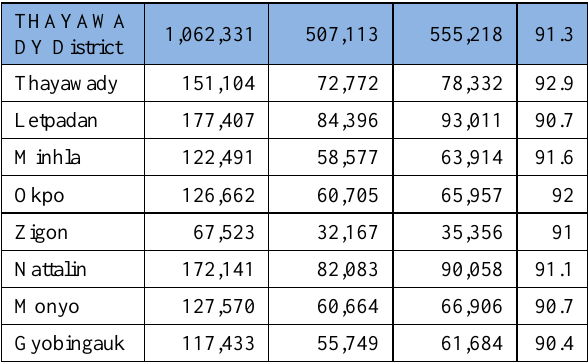
Table 2: Population by household type, sex and sex ratio of Bago Region in 2014 census